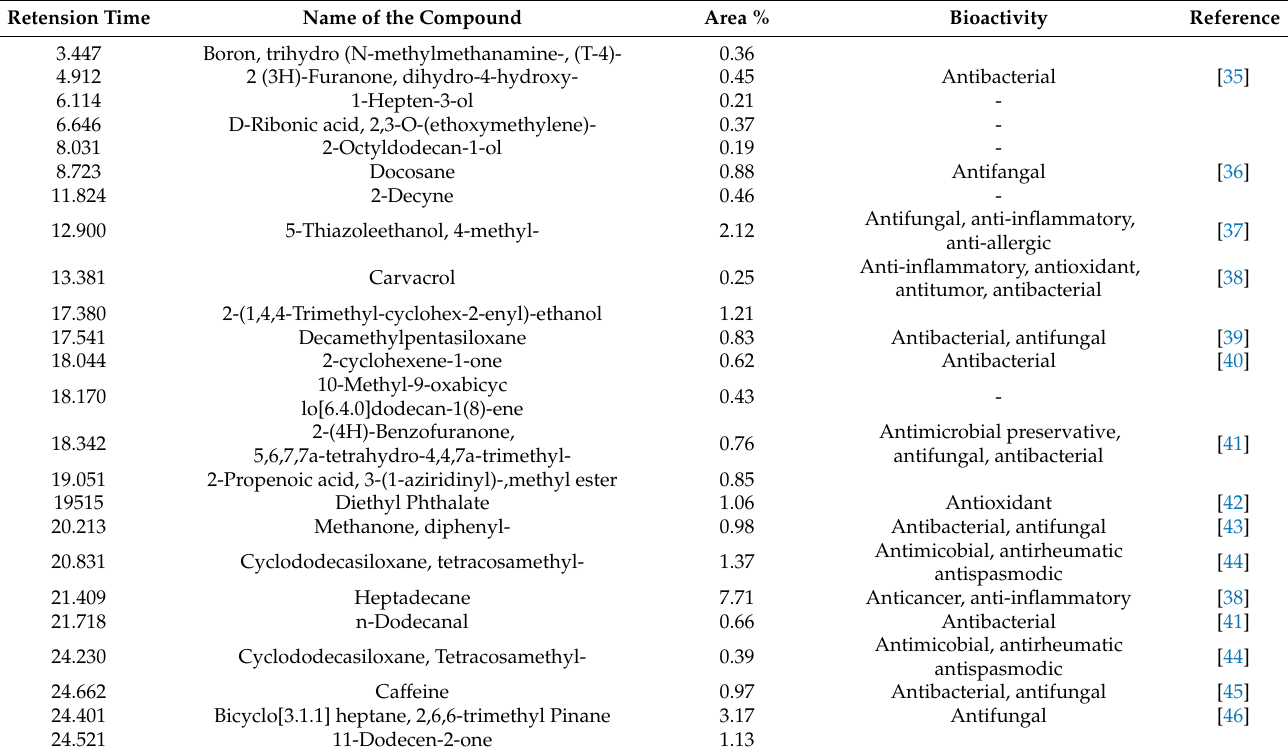
Figure 1. Gas chromatography and mass spectroscopy chromatogram of the methanolic extract of the Gracilariopsis persica alga. Table 1. The phytocomponents were detected in the methanolic extract of the Gracilariopsis persica using gas chromatography and mass